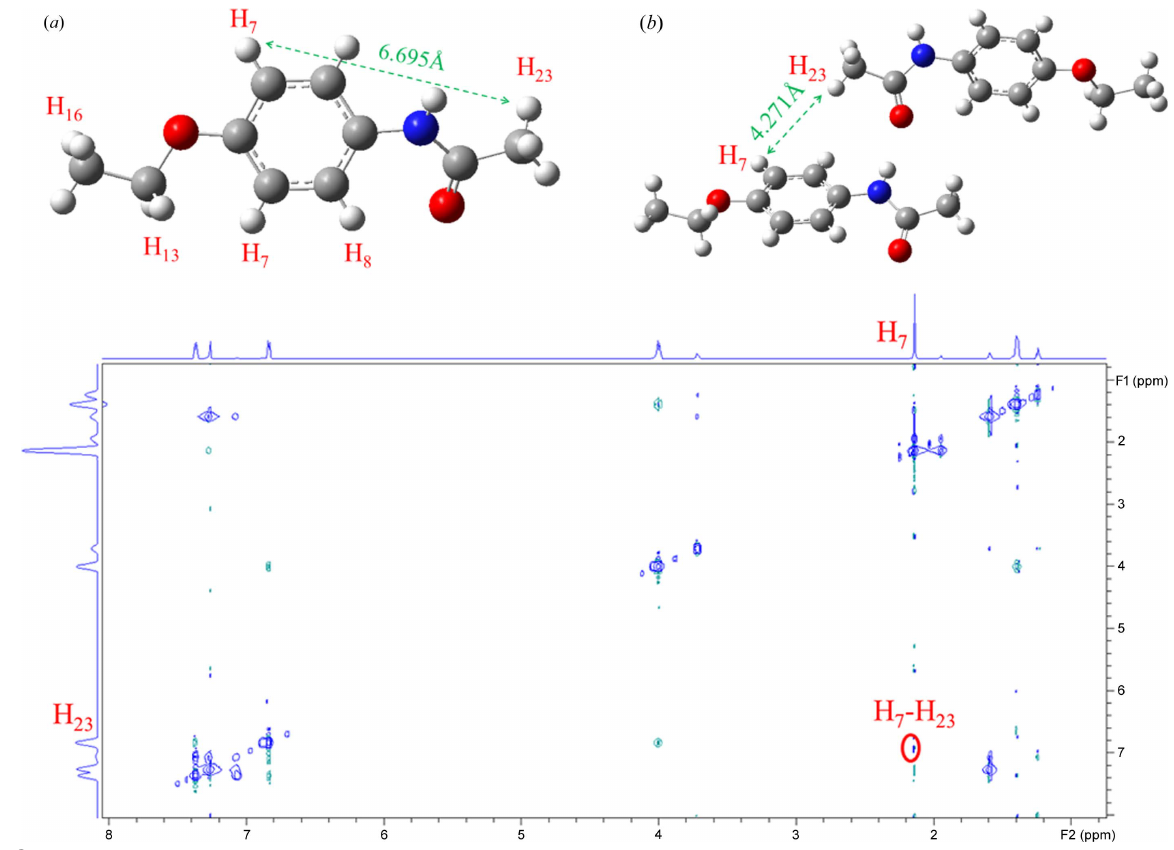
Figure 9 Top: ( a ) distance between H 7 and H 23 in a PHEN molecule, ( b ) distance between H 7 and H 23 while PHEN molecules assemble by forming a C O (cid:8)(cid:8)(cid:8) H— N hydrogen bond. Bottom: 2D NOESY of PHEN in chloroform- d at room temperature.